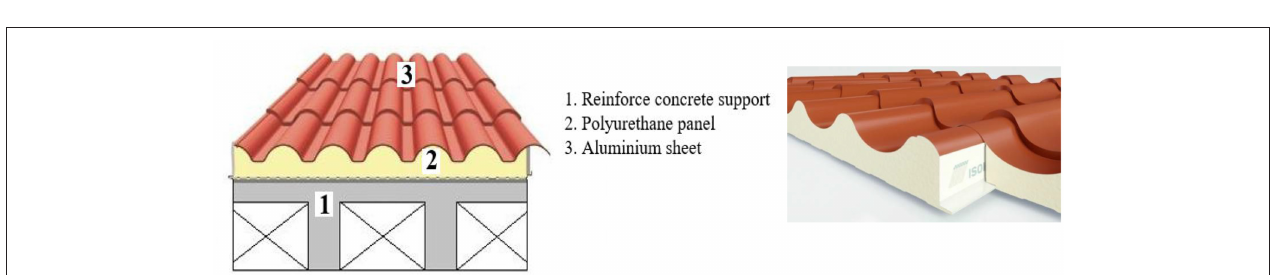
FIGURE 9 | Positioning of polystyrene sheets on the wall: “T” scheme (A) ; “W” scheme (B) .